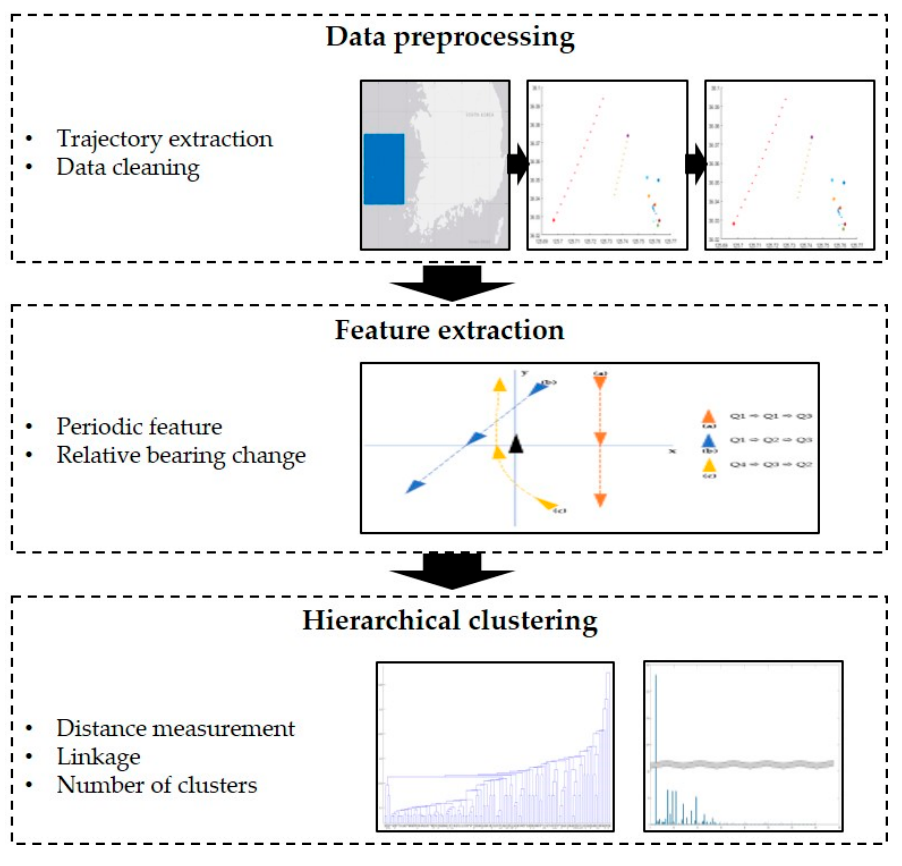
Figure 1. Workflow of methodology.